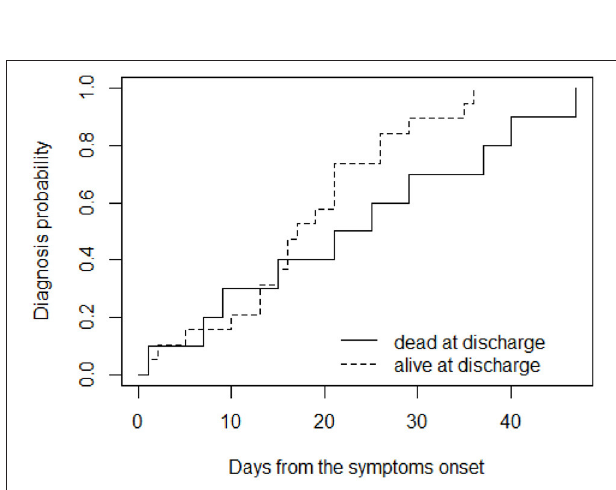
FIGURE 2 | Cumulative probability of receiving diagnosis over time, for patients grouped according to their outcome at (dead or alive) at